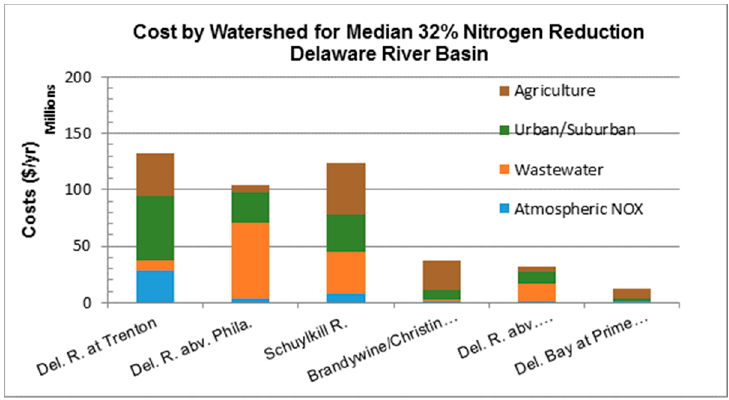
Figure 13. Least cost by watershed to reduce nitrogen loads by 32% in the Delaware Basin. Table 8. Least cost by watershed to reduce nitrogen by the median 32% in the Delaware Basin.